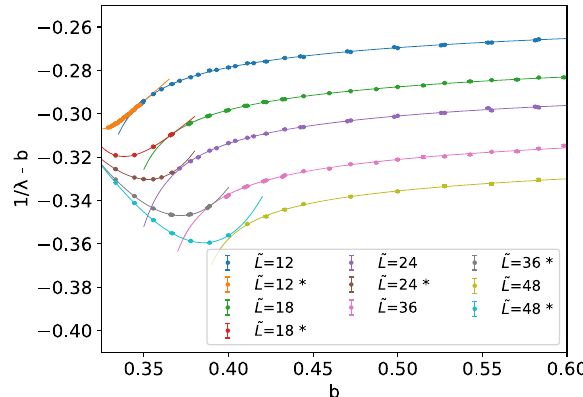
Fig. 4 We display 1 /λ − b as a function of b . The lines represent Padé fits of the form given in Eq. (3.26)